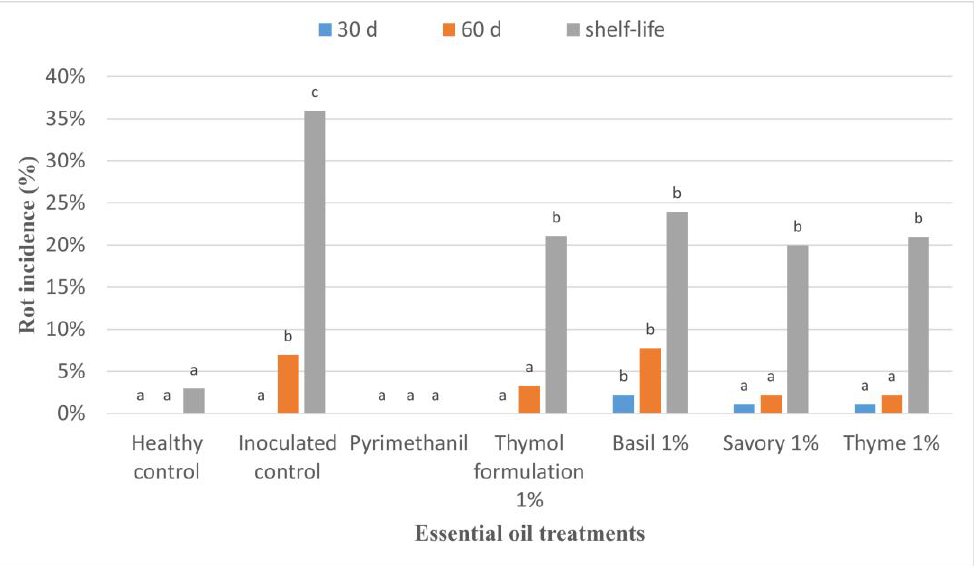
Figure 1. Grey mould incidence on apples ‘Opal’ treated with essential oil biofumigation and stored at 1 ± 1°C and 95 % relative humidity for 60 days and kept in shelf-life at 23 ± 1 °C for 10 days. Values at the same time point, followed by the same letter, are not statistically different by Tukey’s test ( p < 0.05).